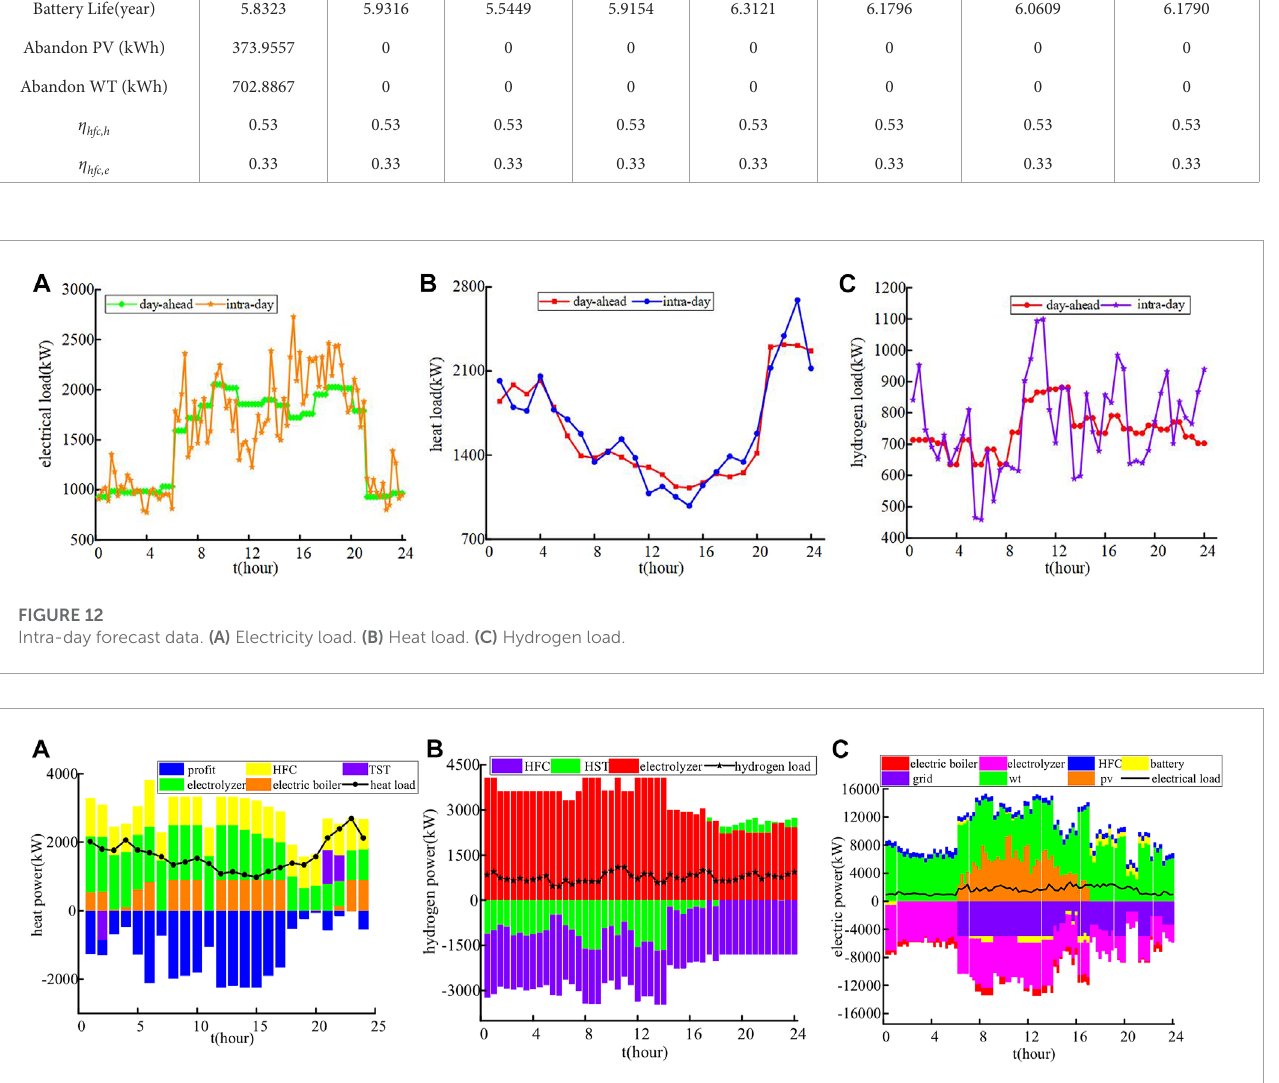
FIGURE 13 Intra-day operation. (A) Heat balance. (B) Hydrogen balance. (C) Electrical power